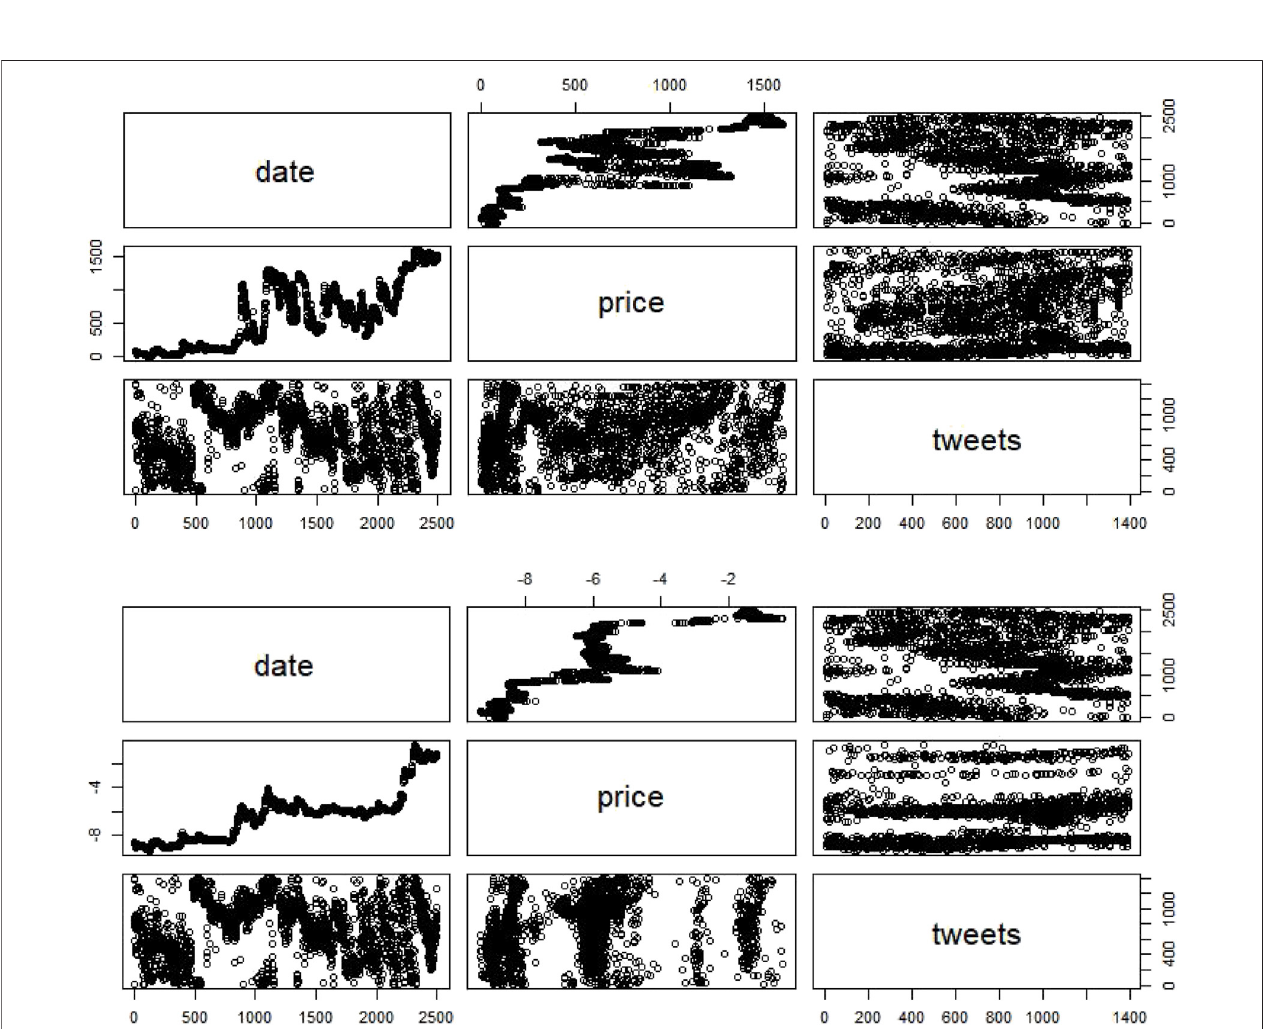
FIGURE 3 | Dogecoin non-stationary and stationary